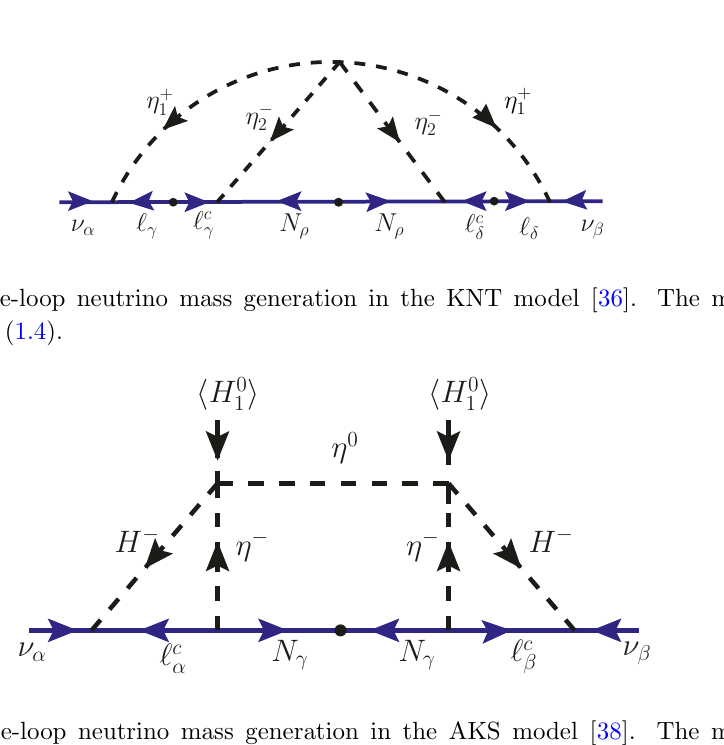
Figure 53 . Three-loop neutrino mass generation in the AKS model [38]. The model induces 0 operator of eq. 3 O